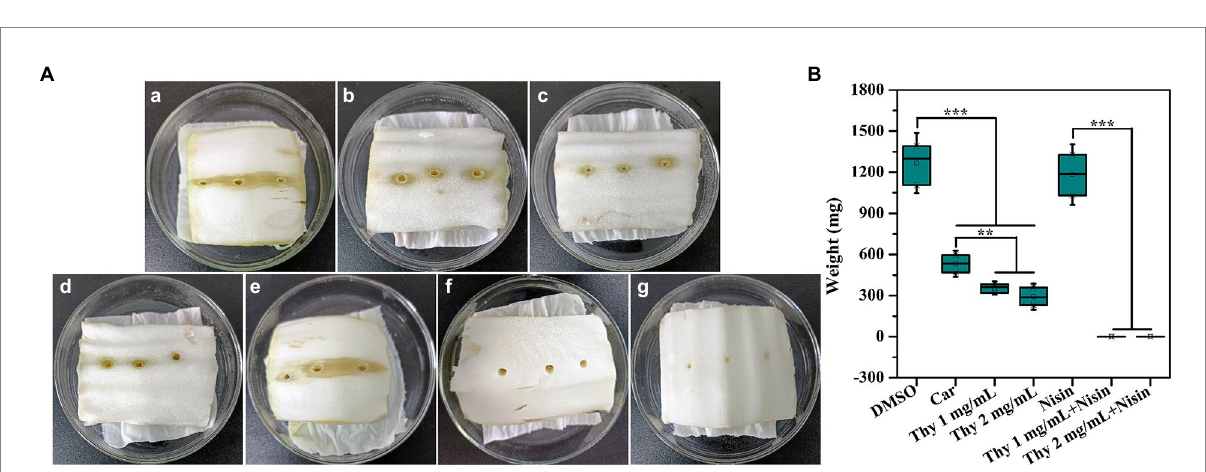
FIGURE 10 Effect of thymoquinone on lettuce infections. (A) Pictures of inoculation of P. aeruginosa PAO1 into lettuces treated with (a) DMSO, (b) 1 mg/ml of carvacrol, (c) 1 mg/ml of thymoquinone, (d) 2 mg/ml of thymoquinone, (e) 1 mg/ml of nisin, (f) 1 mg/ml of nisin +1 mg/ml of thymoquinone, and (g) 1 mg/ml of nisin +2 mg/ml of thymoquinone. DMSO and carvacrol were used as negative and positive control, respectively. (B) Quantification of soft-rot weight of lettuces treated with or without thymoquinone. ( ∗∗∗ ) p < 0.001 versus the DMSO